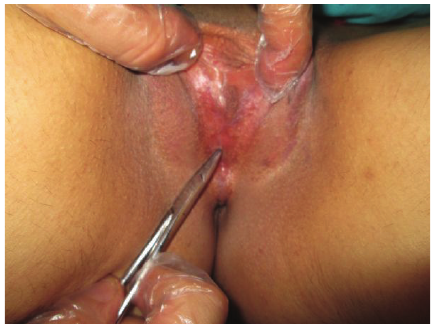
Figure 2: First surgical intervention.